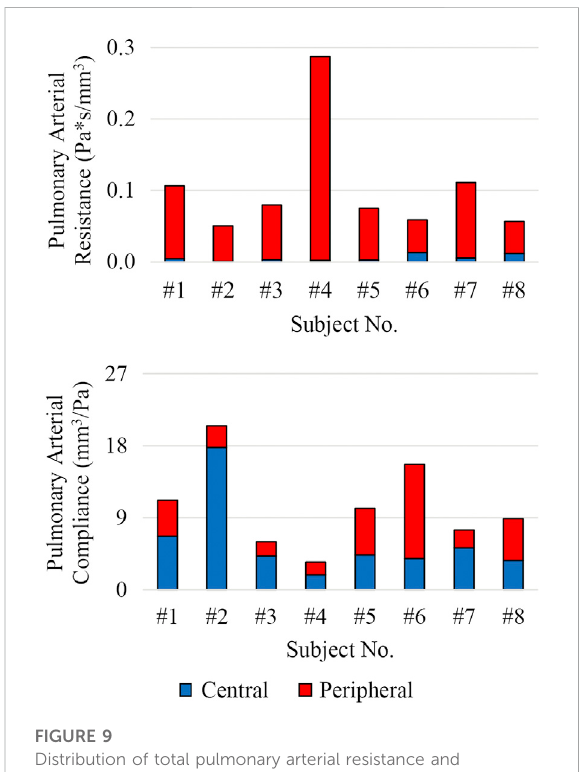
FIGURE 9 Distribution of total pulmonary arterial resistance and compliance between central (3D model, shown in blue) and peripheral (lumped-parameter models, shown in red) pulmonary